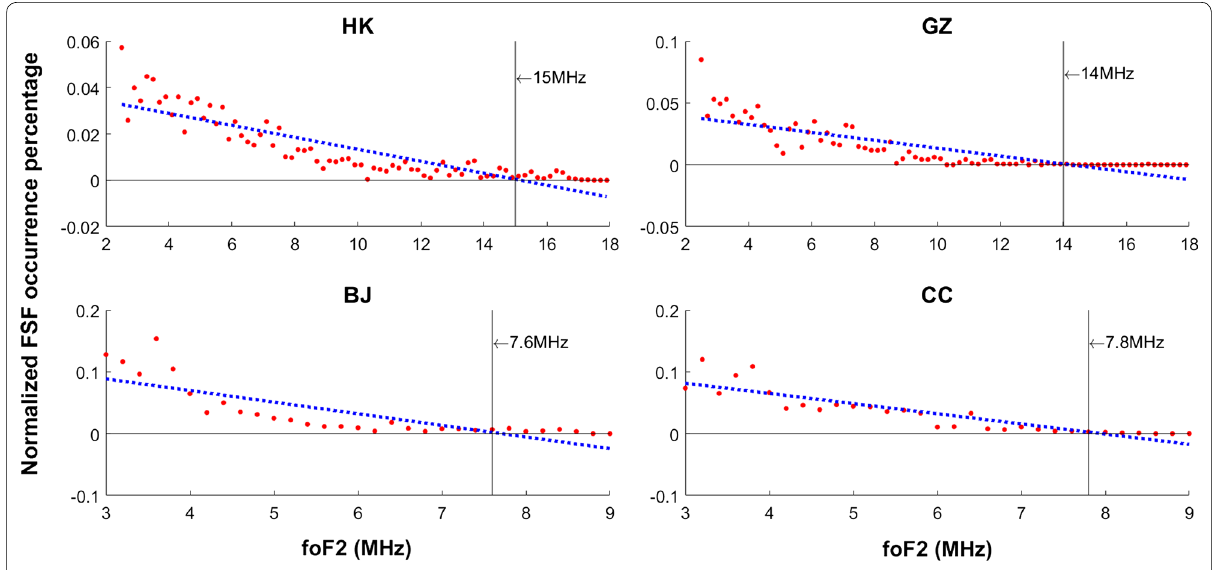
Fig. 12 Correlation between foF2 and the normalized FSF occurrence percentages